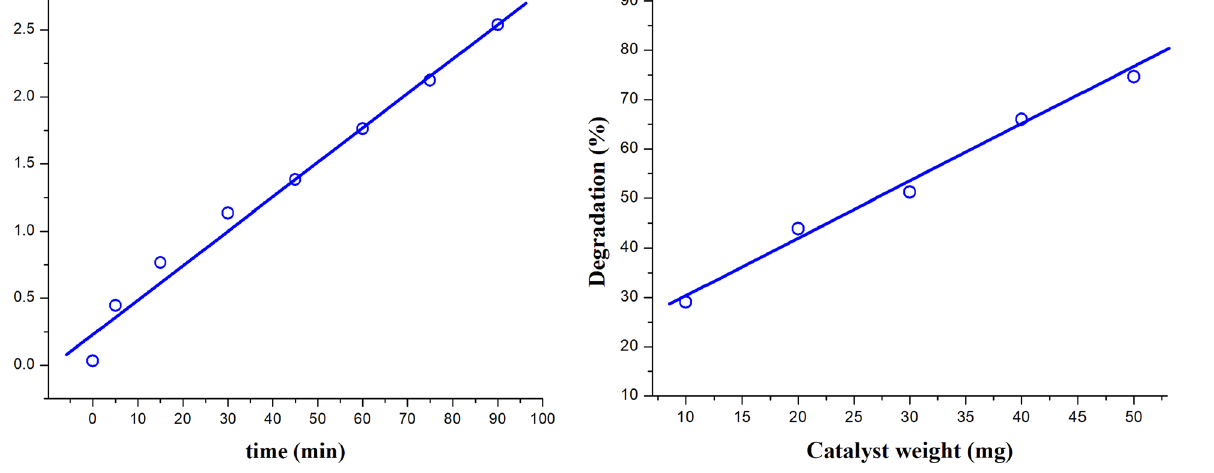
Figure 12: E ff ect of Fe – ZnO - 5 photocatalyst loading on MO dye degradation under solar